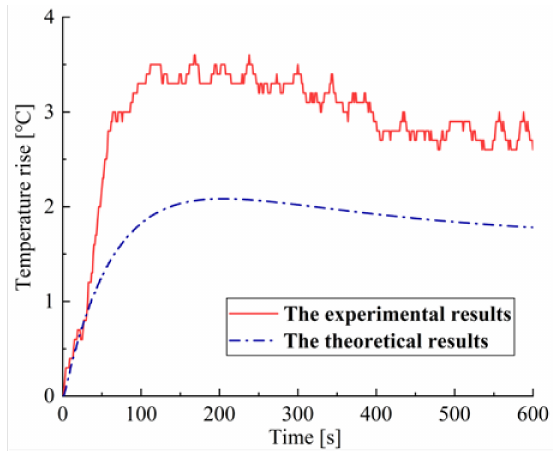
Figure 19. Comparison of the theoretical calculation and test